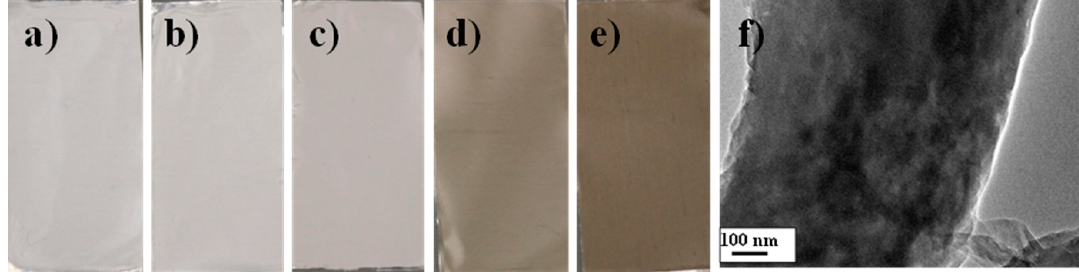
Figure 2. Photography of the as-prepared electrospun mate ( a ) PAN, ( b ) PAN/LCGO-B, ( c ) PAN/LCGO-C, ( d ) PAN/LCGO-D, and ( e ) PAN/LCGO-E, ( f ) TEM image of PAN/LCGO-D shows distribution of LCGO sheets through the nanofibrous structure.